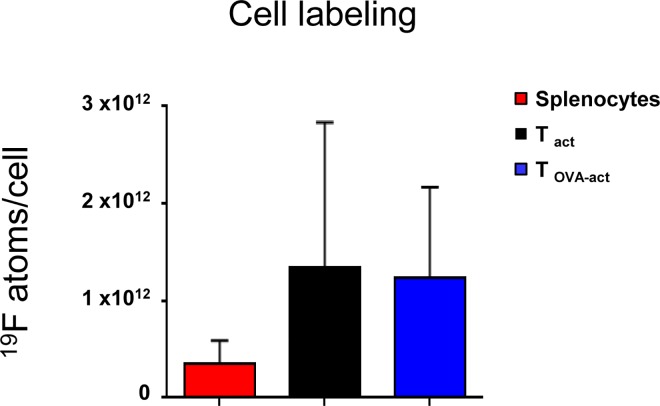
In vitro cell labeling.19F content (number of 19F atoms per cell) in SP, Tact and TOVA-act after incubation with PFC for 18h. Cellular loading was determined in a known number of cells by using an internal reference (TFA) with a known number of 19F atoms.